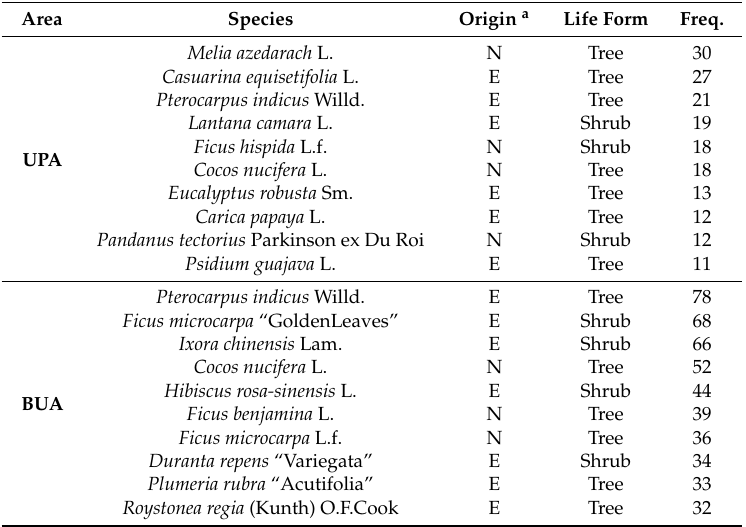
Table 5. Top ten most frequently occurring woody plant species recorded in the built-up area (BUA) and the urban planning area (UPA).